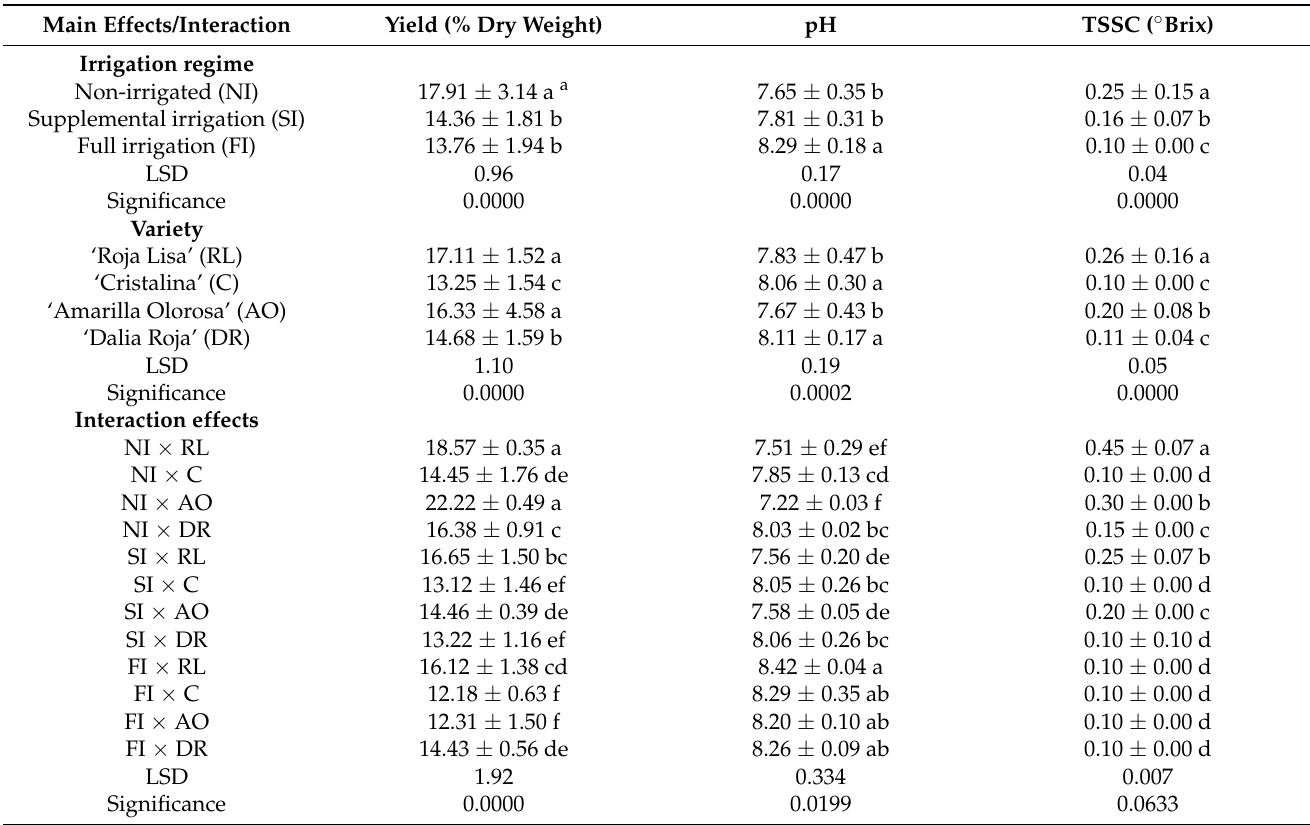
Table 1. Yield, pH, and total soluble solids concentration (TSSC, ◦ Brix) of freeze-dried mucilage from cladodes of Opuntia varieties subjected to irrigation